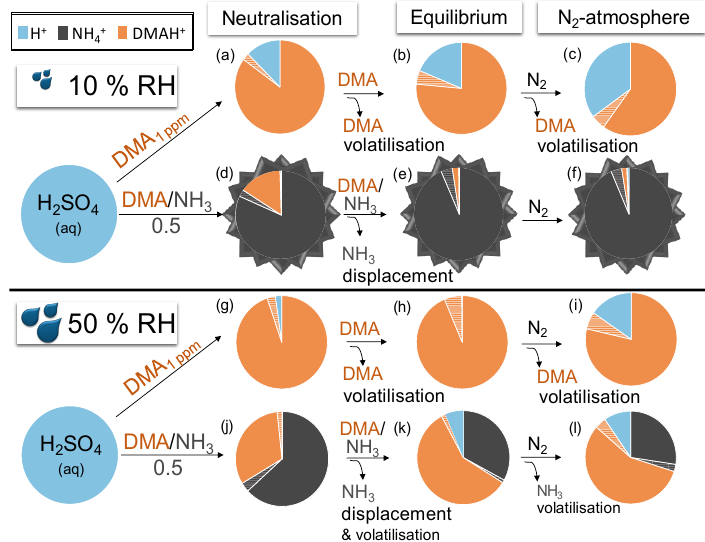
Figure 9. Particle neutralisation ratios and the proportion of each cation at maximum neutralisation (first column), equilibrium (second column) and after exposure of equilibrated particles to N 2 gas (third column). Colour scheme: orange represents DMAH, grey represents NH 4 , shaded areas indicate uncertainty of the respective species and blue represents H 3 O + (HSO − particles were crystalline solids. Concentrations of DMA and NH 3 are shown in Table